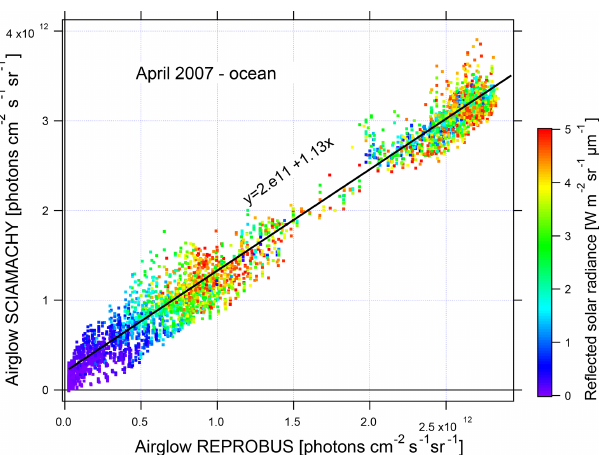
Figure 20. Nadir airglow SCIAMACHY observed intensities ver- sus REPROBUS v02 simulation (same units on both axes, pho- tonscm − 2 s − 1 sr − 1 ). The dots are coloured according to the re- flected solar radiance from 0 in blue to 5Wm − 2 sr − 1 in red. Linear regression of the correlation is in black. Airglow intensity values are expressed in phcm − 2 s − 1 sr − 1